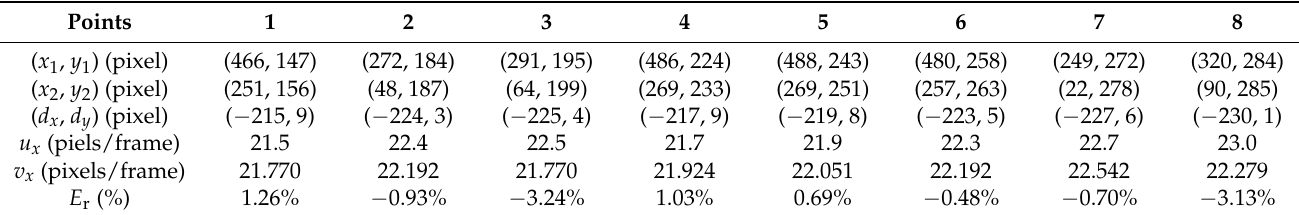
Table 6. Comparison of visual measurements and FFT-STIV measurements.